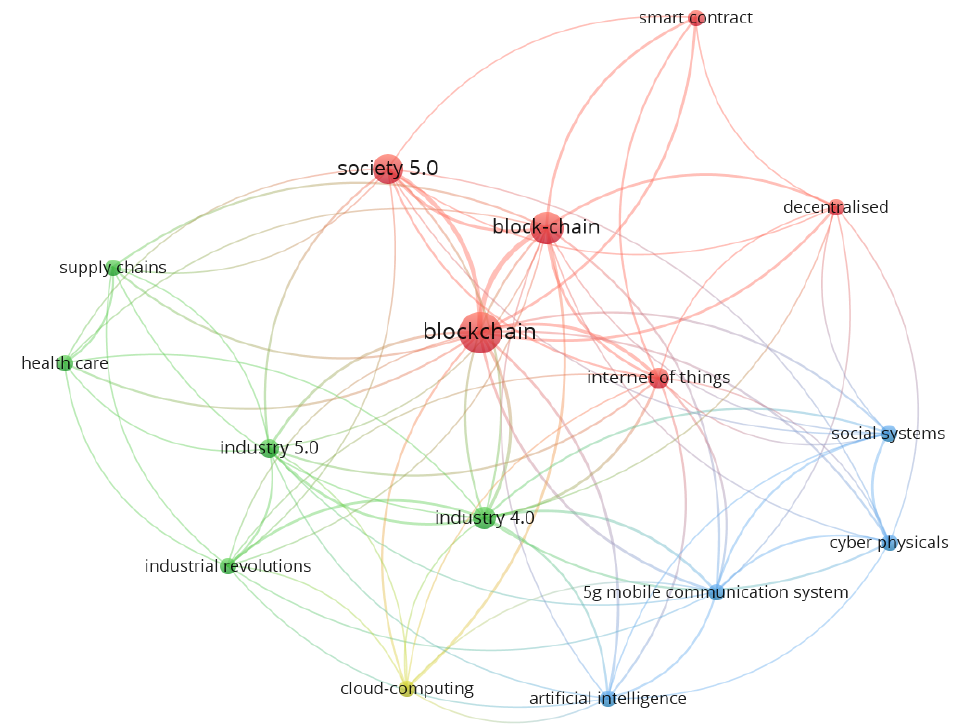
Figure 12. Keyword network for “blockchain” and “Society 5.0.”